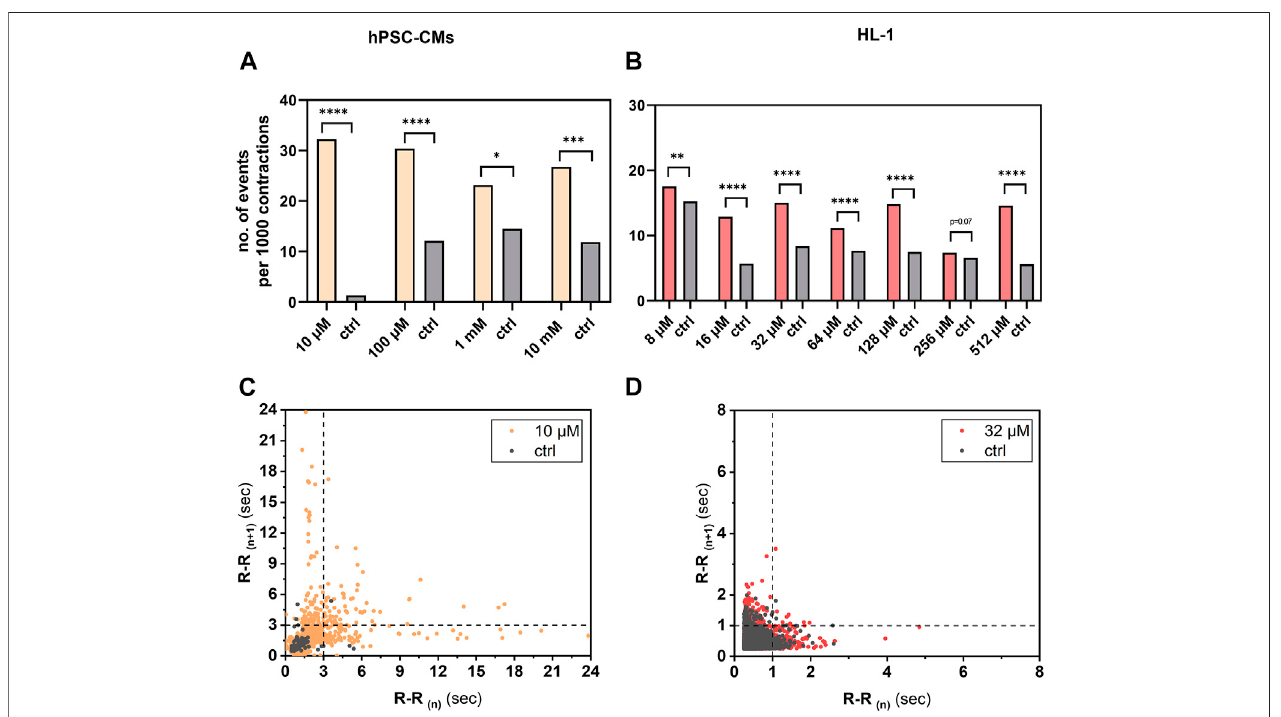
FIGURE5| AnalysisofarrhythmogeniceffectofaminophyllineonhPSC-CMsandHL-1cells.R-Rvaluesover3 sincaseofhPSC-CMmeasurementsor1 sincase of HL-1 of aminophylline and control measurements were subtracted, and the resulting contingency tables were statistically analyzed. Column graphs show sums of cutoff R-R values (arrhythmic events) per 1,000 contractions in each treatment group and controls of (A) hPSC-CMs and (B) HL-1 experiments (chi-square test with Yates ’ correction). Results show signi fi cant or partially signi fi cant higher frequency of aminophylline group cutoff values compared to that of the control. Poincaré plots of R-R values of representative concentration for (C) hPSC-CMs and (D) HL-1 experiments with visible cutoff lines.